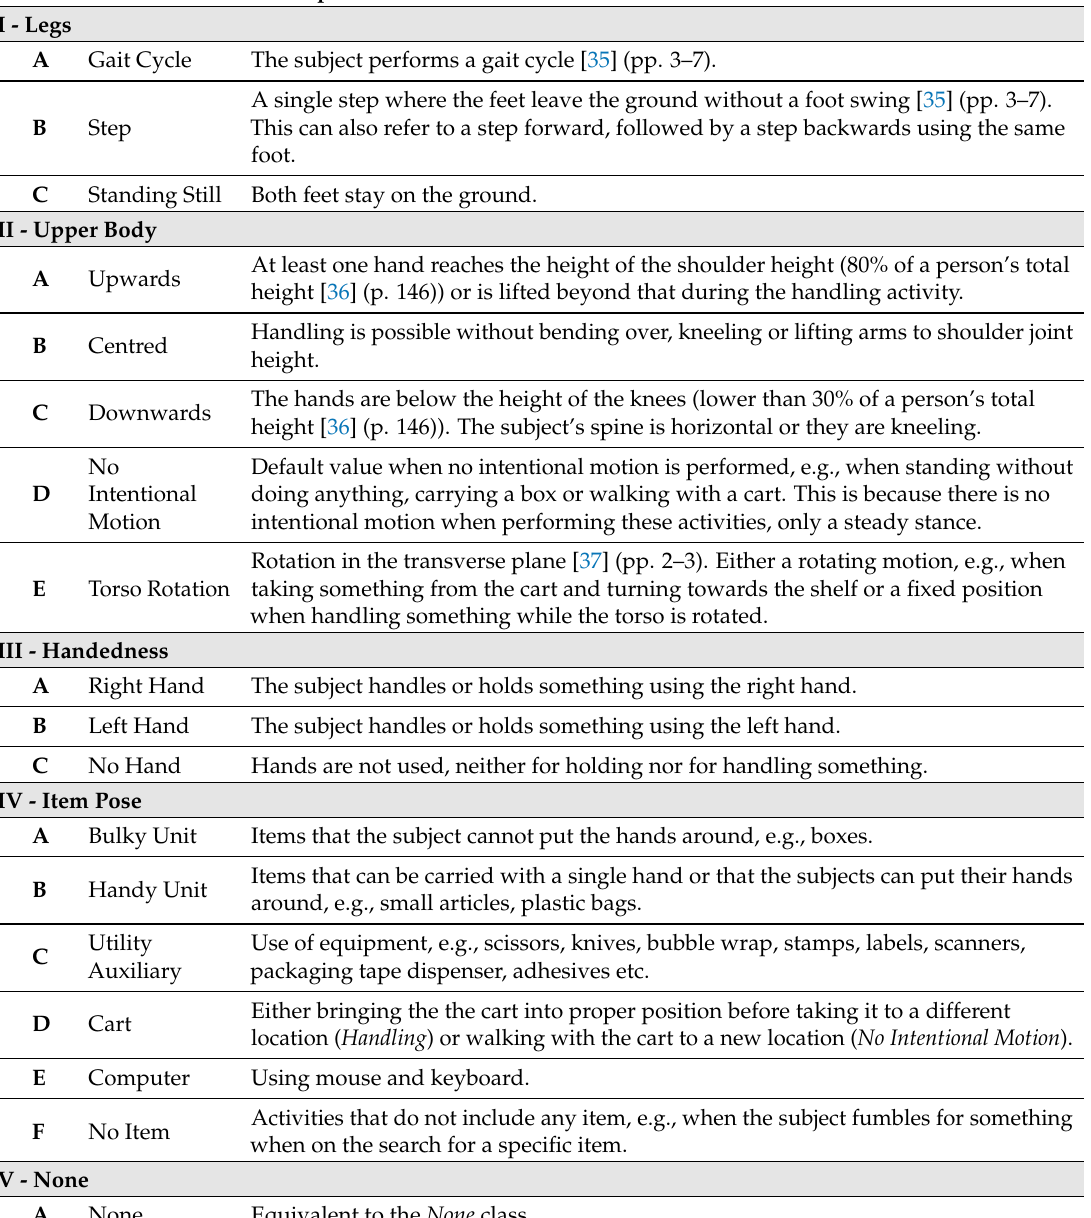
Table 3. Attributes and their semantic